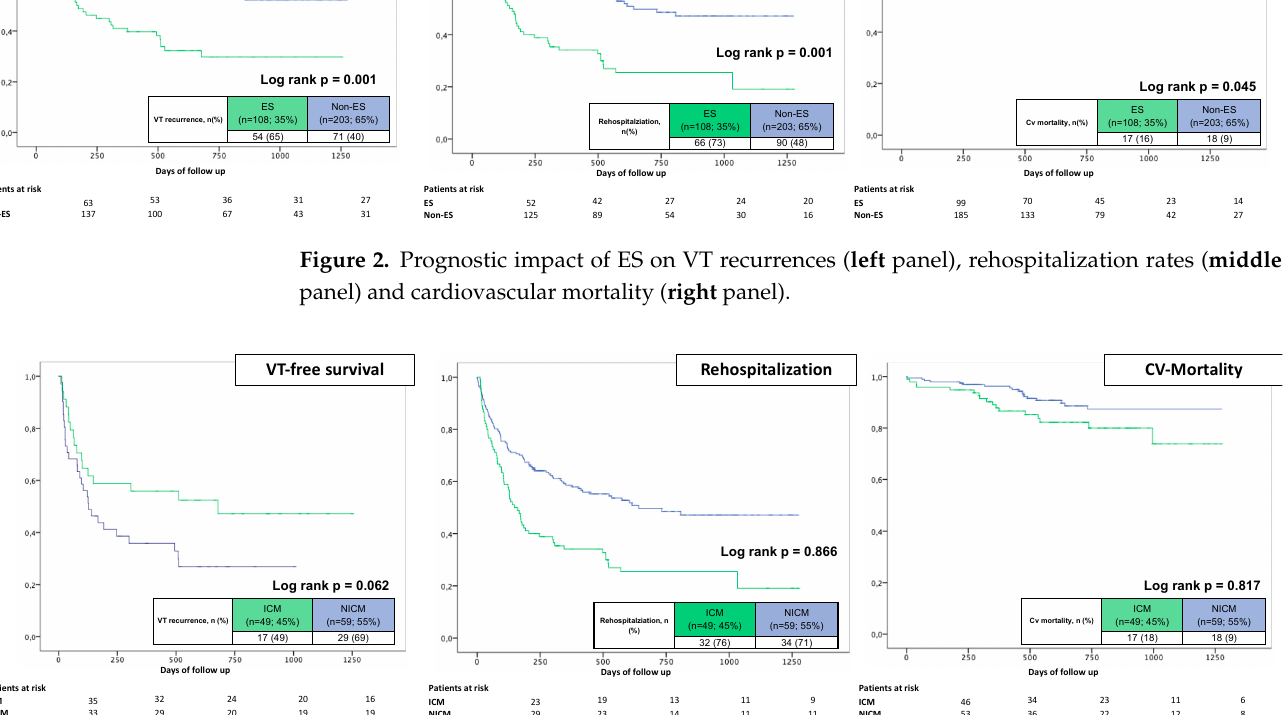
Figure 3. Prognostic impact of ICM and NICM on VT recurrences ( left panel), rehospitalization rates ( middle panel) and cardiovascular mortality ( right panel) in ES patients. Table 4. Primary and secondary endpoints.